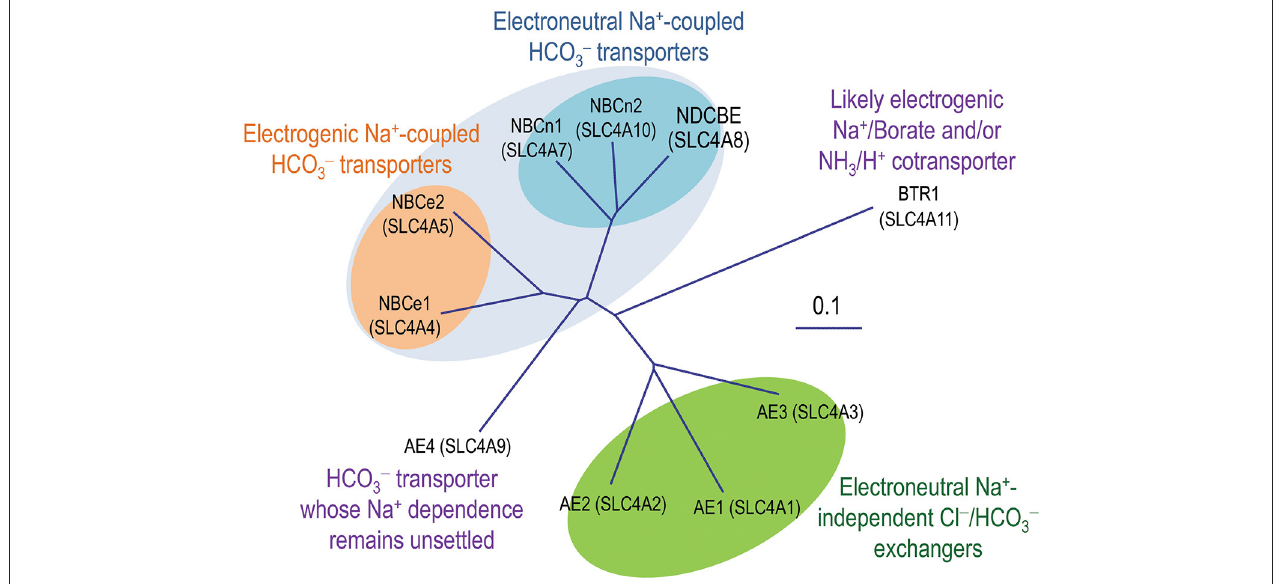
FIGURE 1 | Phylogenetic tree of SLC4 family. A multiple sequence alignment was performed with human sequences of eAE1 (NP_000333.1), AE2a (NP_003031.3), bAE3 (NP_005061.2), AE4a (NM_031467), NBCe1-A (AAC51645.1), NBCe2-c (AAK97072.1), NBCn1-E (ACH61961), NBCn2-A (NP_071341.2),